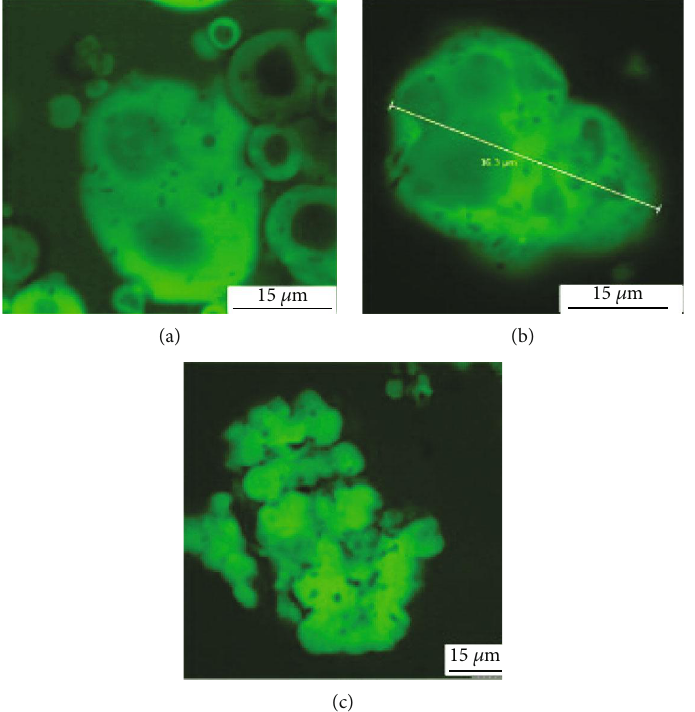
Figure 4: Confocal laser scanning microscopy micrographs showing the integrity of microencapsulated LGG formulations containing (a) WPI, (b) 1WPI:1RS, and (c) RS dispersed in apple juice. The micrographs were taken 24 hours after dispersion of the microencapsulated LGG